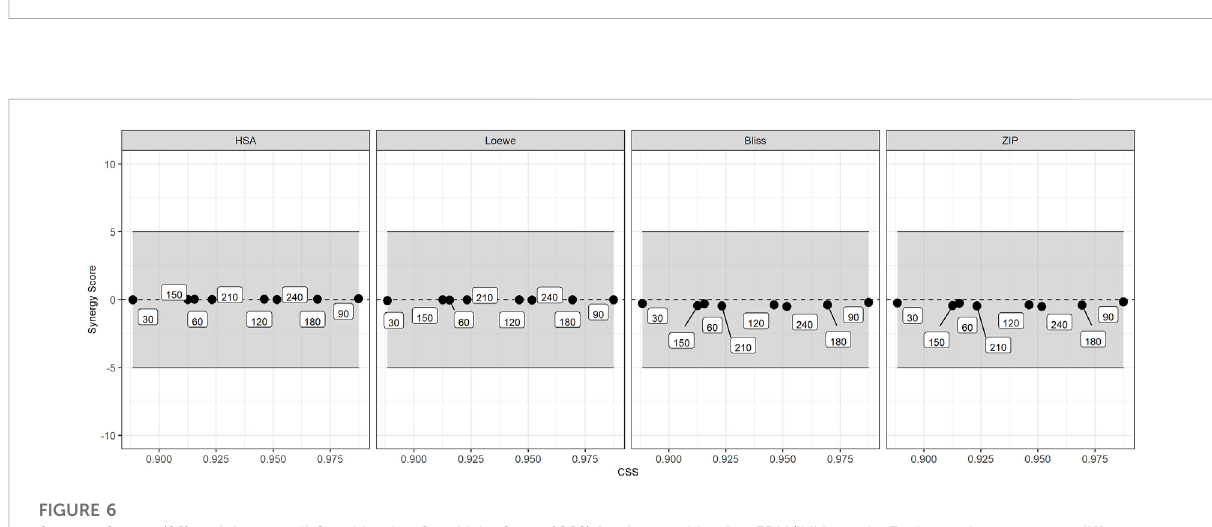
FIGURE 5 Heatmaps of the dose-response matrix for EPM and IVM drug-drug interaction . Exposure time at 30 min (A) and 90 min (B) . Mean value of the dose-response matrixis indicatedatthetop ( p valuecomparedto0%inhibition). Nosigni fi cant change ininhibition (red orgreen) between EPM and IVM at all concentrations.